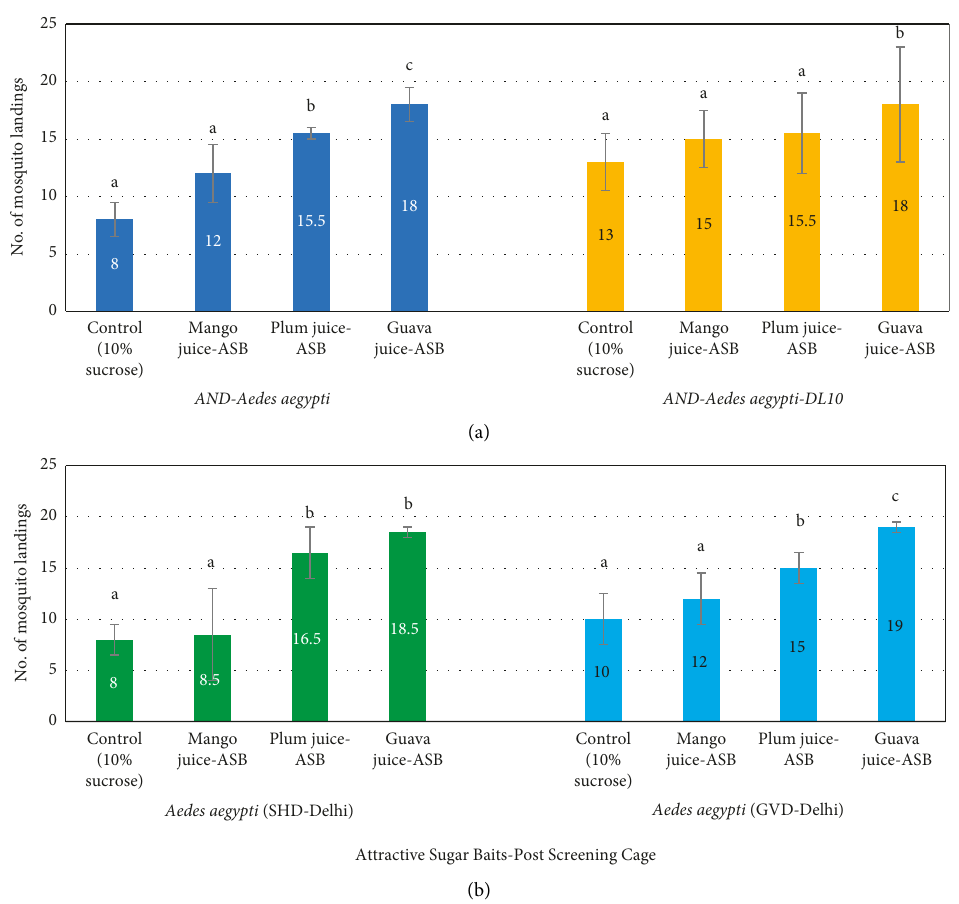
Figure 4: Postscreening assay showing number of landings by laboratory ( AND-Aedes aegypti and AND-Aedes aegypti-DL10 ) and field population Aedes aegypti (SHD-Delhi) and Aedes aegypti (GVD-Delhi) of the three most efficient ASBs placed along with a control in one